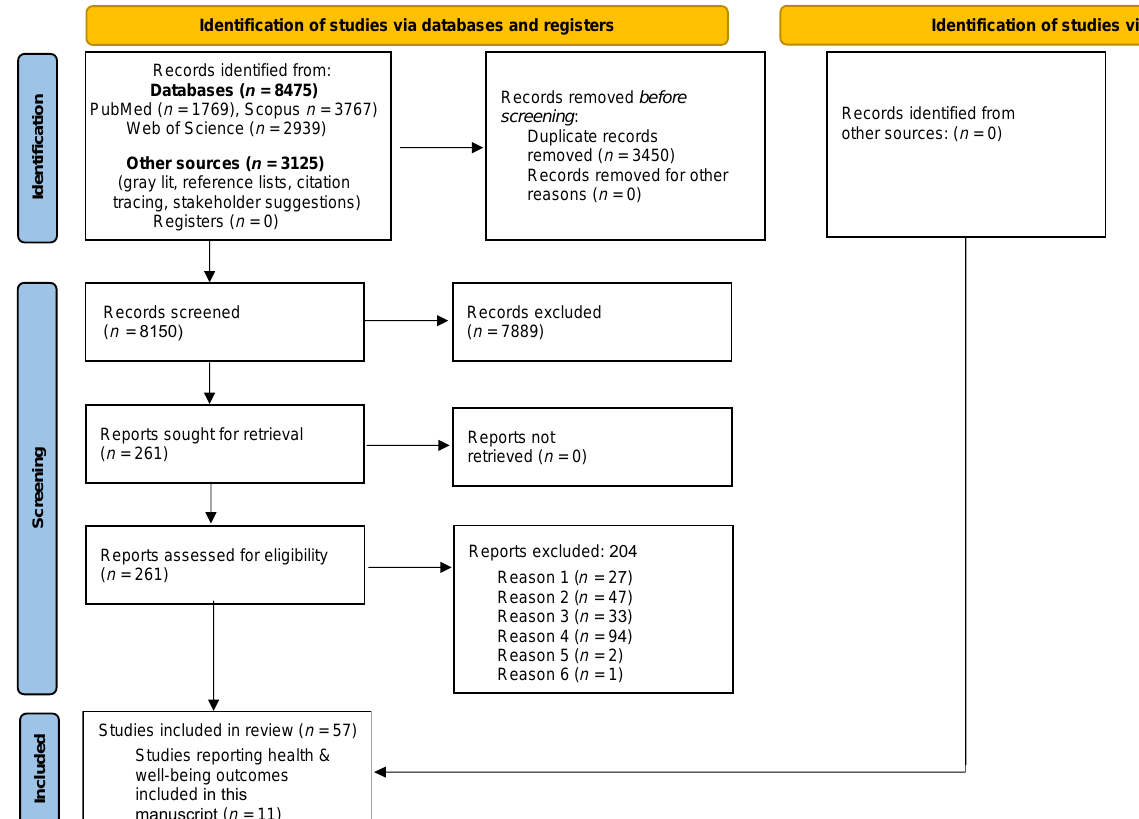
Figure 1. The flow diagram of study identification, screening, and inclusion. 1. Editorial, commentary, discussion paper, review; 2. No clear initiative implemented; 3. Initiative designed to (i) Facilitate PE or increase exposure to PE; (ii) Improve workers’ health through individual behavioural change without a focus on PE; (iii) Improve work performance or health, safety, or well-being of workers with disabilities without a focus on PE; (iv) Eliminate or reduce workers’ exposure to unemployment; (v) Eliminate, reduce, or mitigate the effects of unemployment on health and well-being; or (vi) Promote workers’ return to work after illness or injury without addressing PE; 4. (i) Not evaluated formally or assessed using empirical data or (ii) The evaluation does not include a clear focus on the reduction of PE and/or on precarious workers and/or their families. 5. Duplicate. 6. Not in a language mentioned in the protocol. PE—precarious